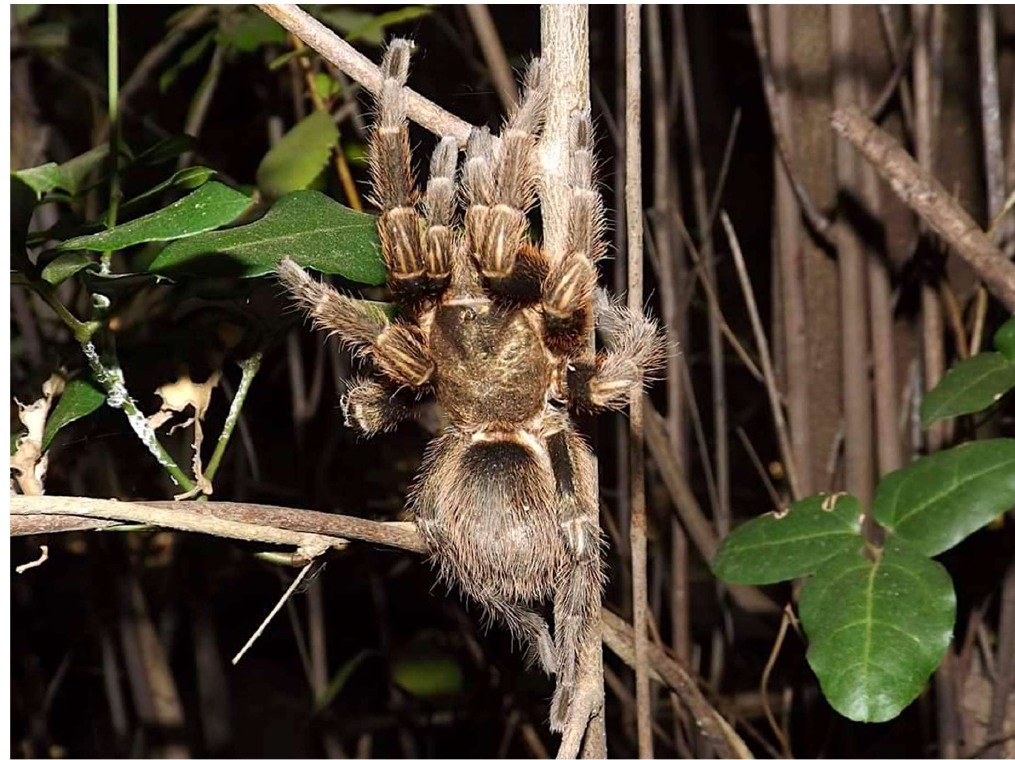
Figure 3. Euathlus sp. climbing a tree. Lliulliu, Valparaíso region, Chile. Photo credit: Asiel Olivares.